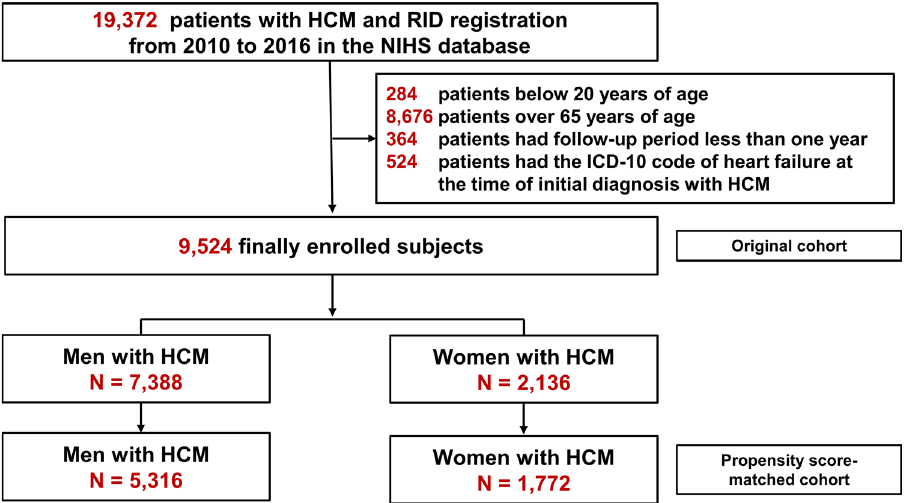
Figure 3. Flow chart of the study participants. HCM hypertrophic cardiomyopathy, RID rare intractable